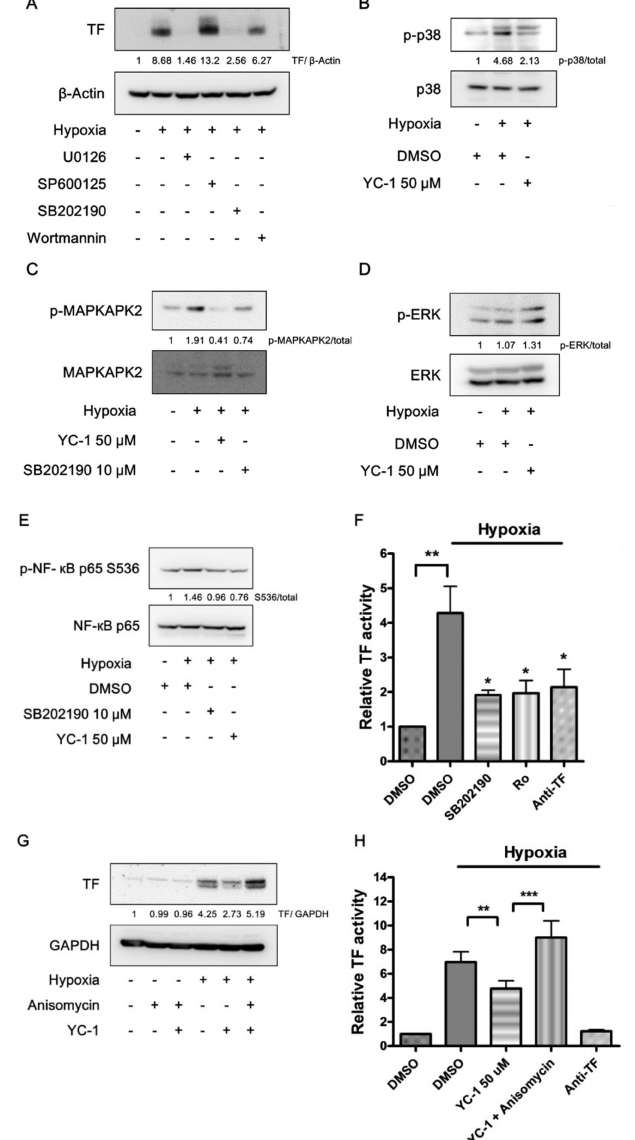
Figure 6. YC-1 prevents hypoxia-induced TF through inhibition of the p38/NF- κ B pathway. ( A ) Effects of specific inhibitors of MAPKs and Akt on hypoxia-induced TF expression. A549 cells were treated with U0126 (10 µ M), SP600125 (10 µ M), SB202190 (10 µ M), and wortmannin (0.1 µ M) for 1 h, and exposed to hypoxia for 24 h. Cell lysates were subjected to Western blotting for TF. ( B , C ) YC-1 inhibits hypoxia-stimulated p38 activation. Cells pretreated with YC-1 were exposed to hypoxia for 15 min ( B ) or 2 h ( C ). Cell lysates were subjected to Western blotting for p38 and MAPKAPK2. ( D ) The effect of YC-1 on ERK activation in hypoxic conditions. A549 cells were treated as in ( B ), and the cell lysates were subjected to Western blotting for ERK. ( E ) The p38 inhibitor prevents hypoxia-induced NF- κ B activation. A549 cells treated with SB202190 (10 µ M) or YC-1 (50 µ M) were exposed to hypoxia for 2 h. Cell lysates were subjected to Western blotting for NF- κ B. ( F ) The p38 and NF- κ B inhibitors prevent hypoxia-induced TF activity. A549 cells treated with SB202190 (10 µ M) or Ro 106-9920 (10 µ M) were exposed to hypoxia for 24 h, then the TF-dependent factor Xa generation was determined. Data are presented as mean ± SEM ( n = 3). * = p < 0.05, ** = p < 0.01. ( G , H ) The p38 activator rescues YC-1 (cid:48) s effect on hypoxia-induced TF expression and procoagulant activity. A549 cells were pretreated with YC-1 (50 µ M) in the absence or presence of anisomycin (0.1 µ M) and exposed to hypoxia for 24 h. The protein levels ( G ) and activity ( H ) of TF were determined by Western blotting and TF-dependent factor Xa generation, respectively. Data are presented as mean ± SEM ( n = 3). ** = p < 0.01, *** = p <